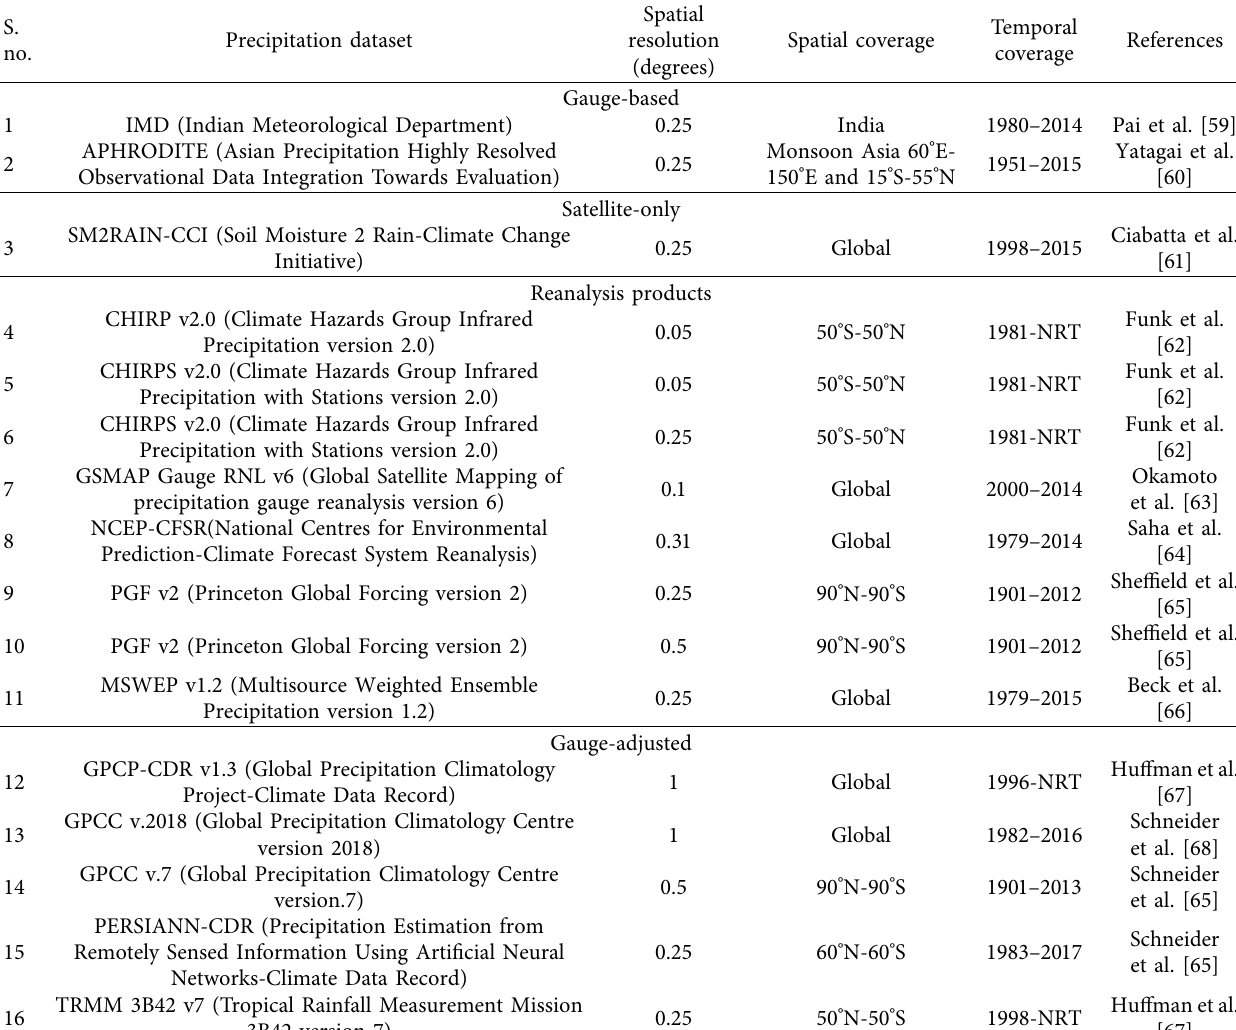
Table 1: Overview of the 16 daily (or subdaily) gridded precipitation datasets evaluated in this study. S.